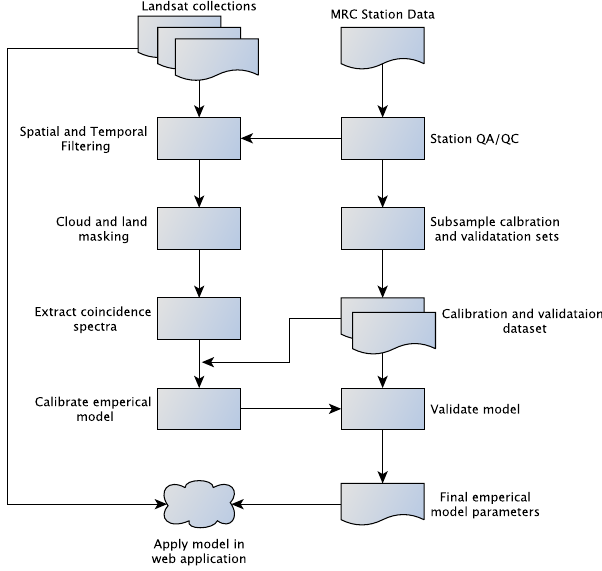
Figure 2. General workflow schematic for building SSSC empirical model from satellite